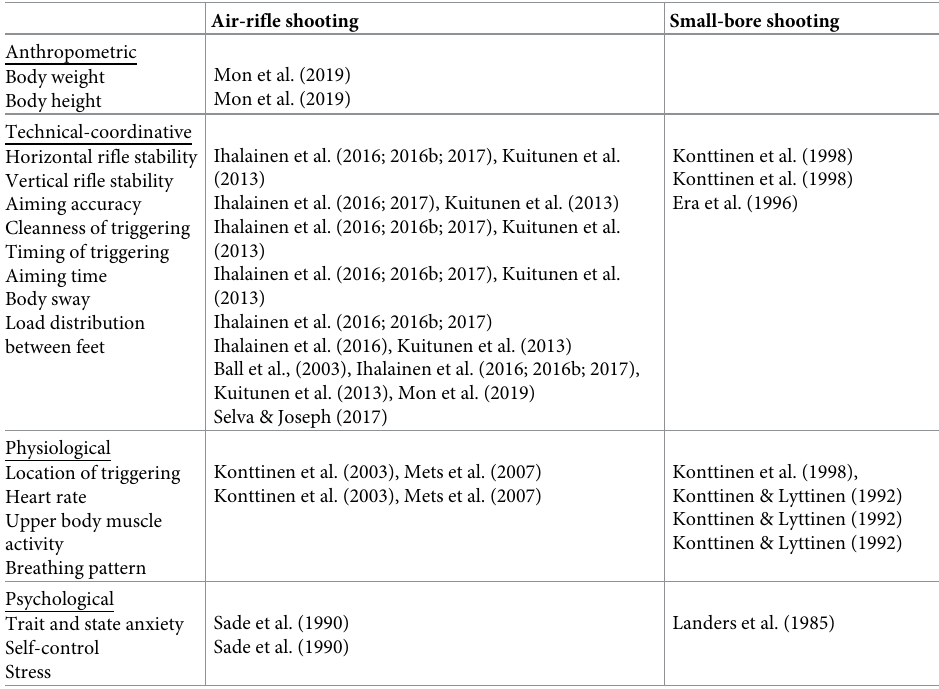
Table 2. Investigated performance determinants in air-rifle and small-bore shooting (performance determinants are described in the results